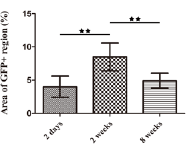
Figure 5. Histomorphometric analysis. The graph shows the area of GFP positive regions for the different study groups. ( ww , represents p ,